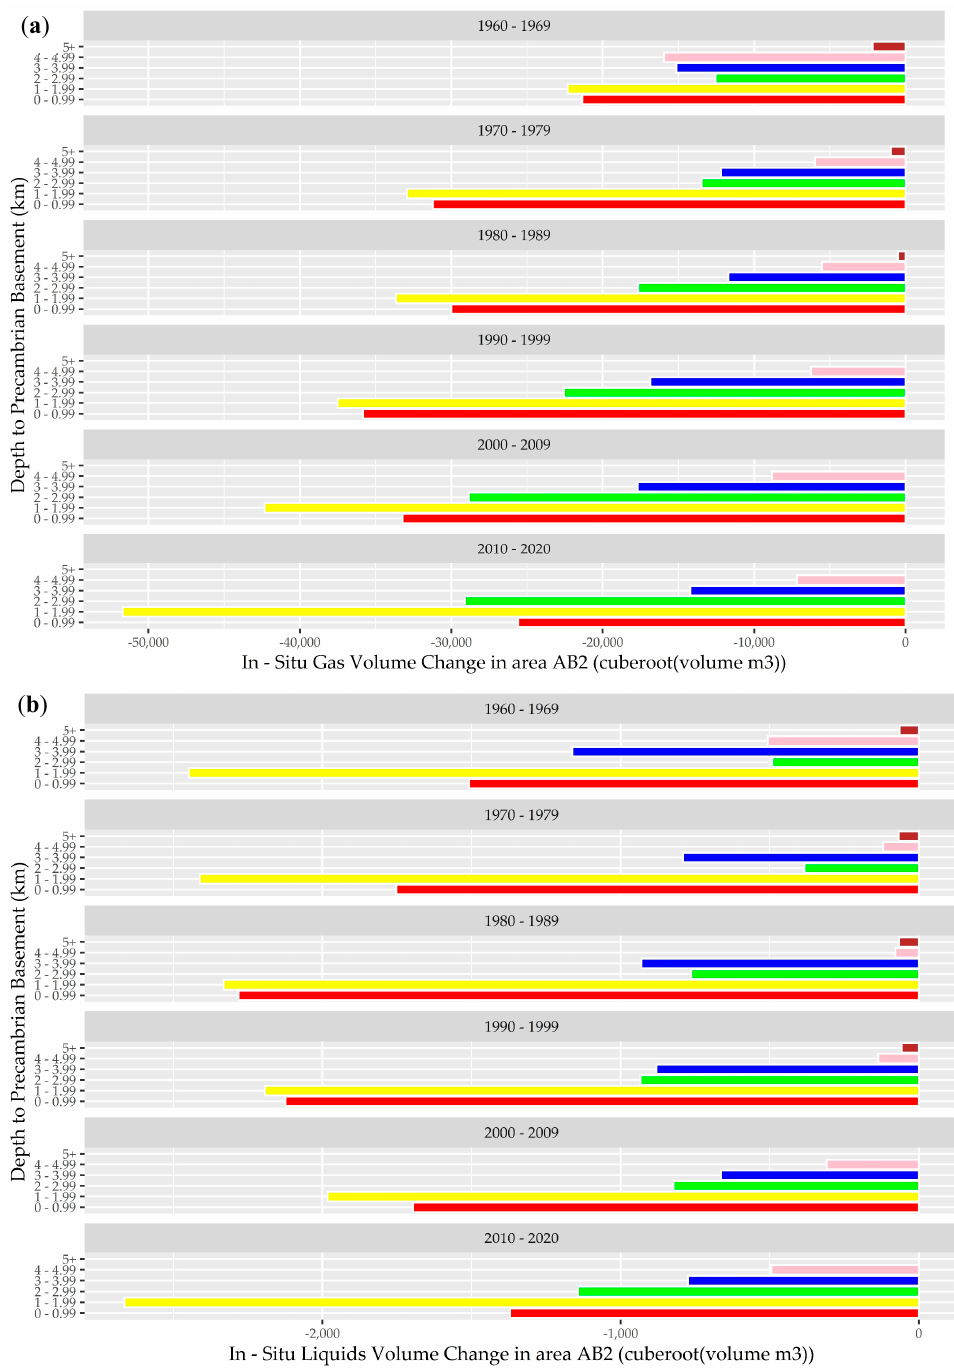
Figure 4. Calculated net in situ ( a ) gas and ( b ) liquid balance for AB2 over the period January 1960–December 2020. Red bars: <1 km depth from Precambrian basement; Yellow bars: 1–2 km depth from Precambrian basement; Green bars: 2–3 km depth from Precambrian basement; Blue bars: 3–4 km frm Precambrian basement; Pink bars: 4–5 km depth from Precambrian basement; Brown bars: 5+ km depth from Precambrian basement. Source data extracted from geoLOGIC Systems databases ©